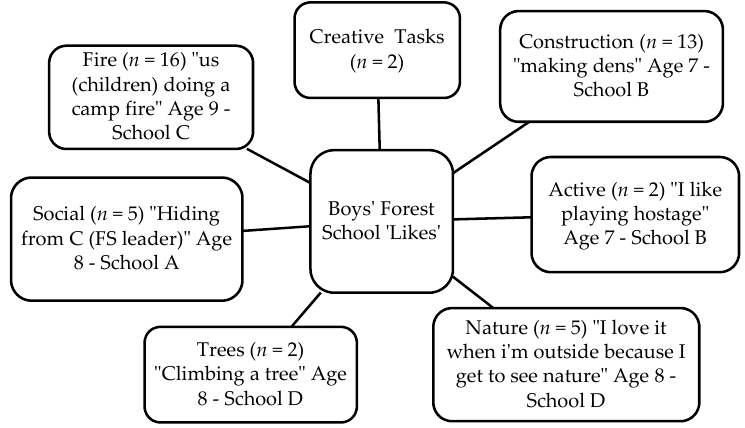
Figure 4. Pen profiles for boys’ answers to “What I like about Forest School is…?”.